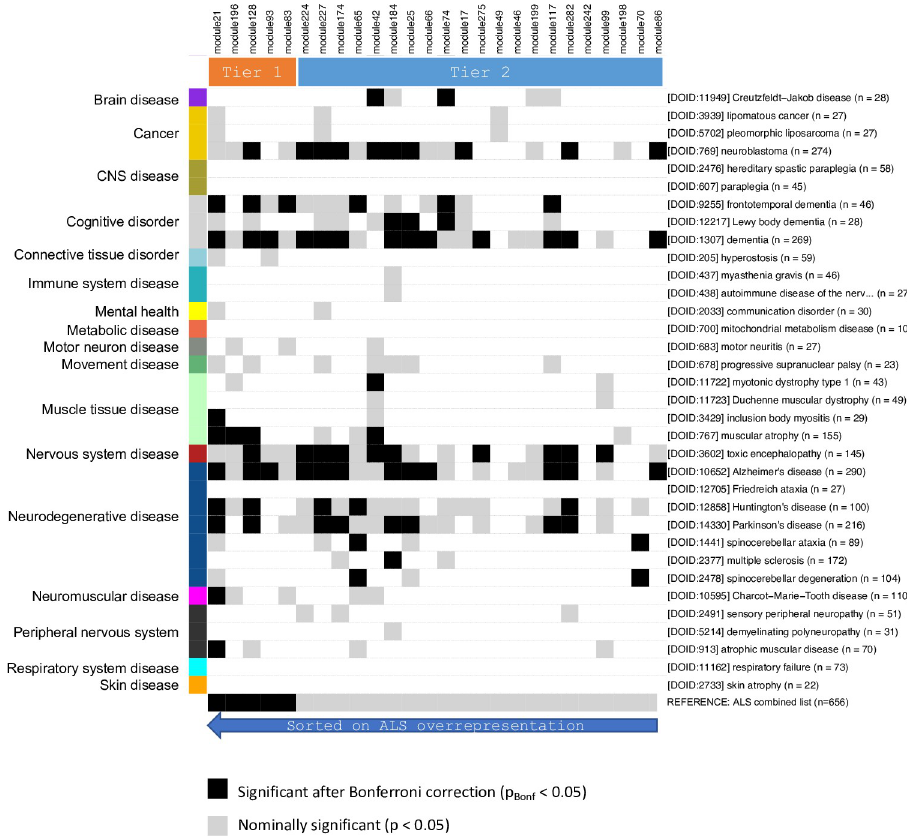
Fig 4. Disease overlap matrix for ALS core modules. Top row: Module IDs–sorted on significance of ALS overrepresentation (most significant to the left), and Tier 1 / Tier 2 subsets indicated. Right side: Disease description: Disease Ontology ID, name (truncated to 35 letters), number of genes/proteins associated to the disease via text mining. Only diseases with a least 20 associated genes/proteins included in this figure. Left: Disease categories as defined in Table